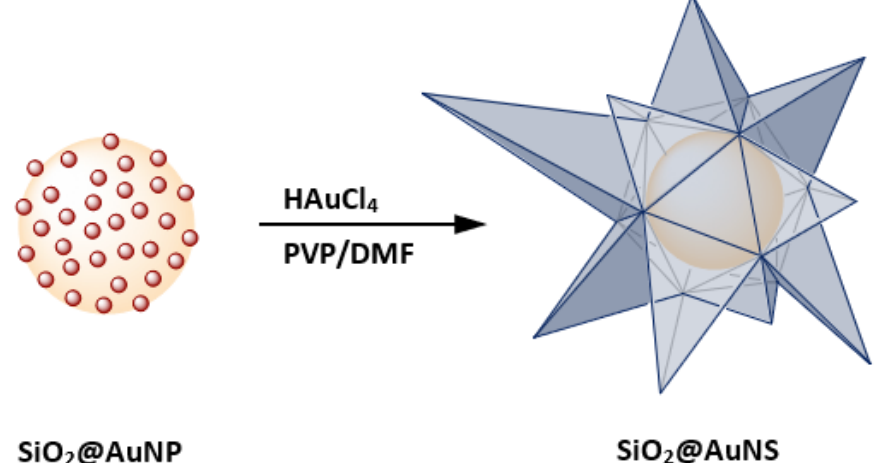
Figure 1. A schematic illustration of the SiO 2 @AuNS core–shell formation based on the coating of SiO 2 @AuNP in PVP/DMF in the presence of HAuCl 4 .